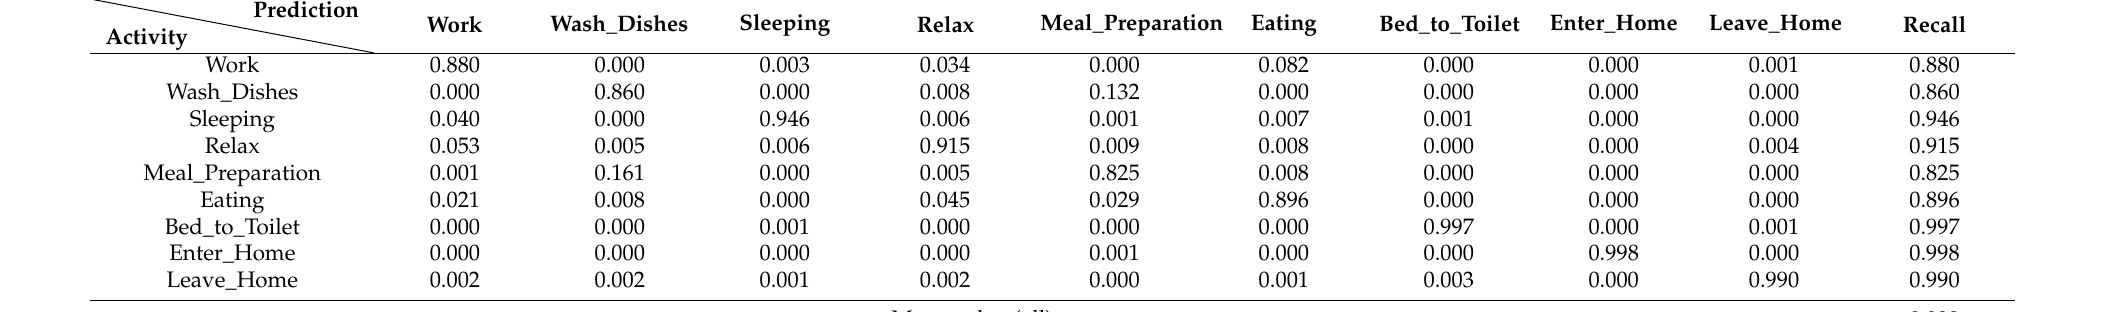
Table 5. Confusion Matrix for Remaining Activities and Recall